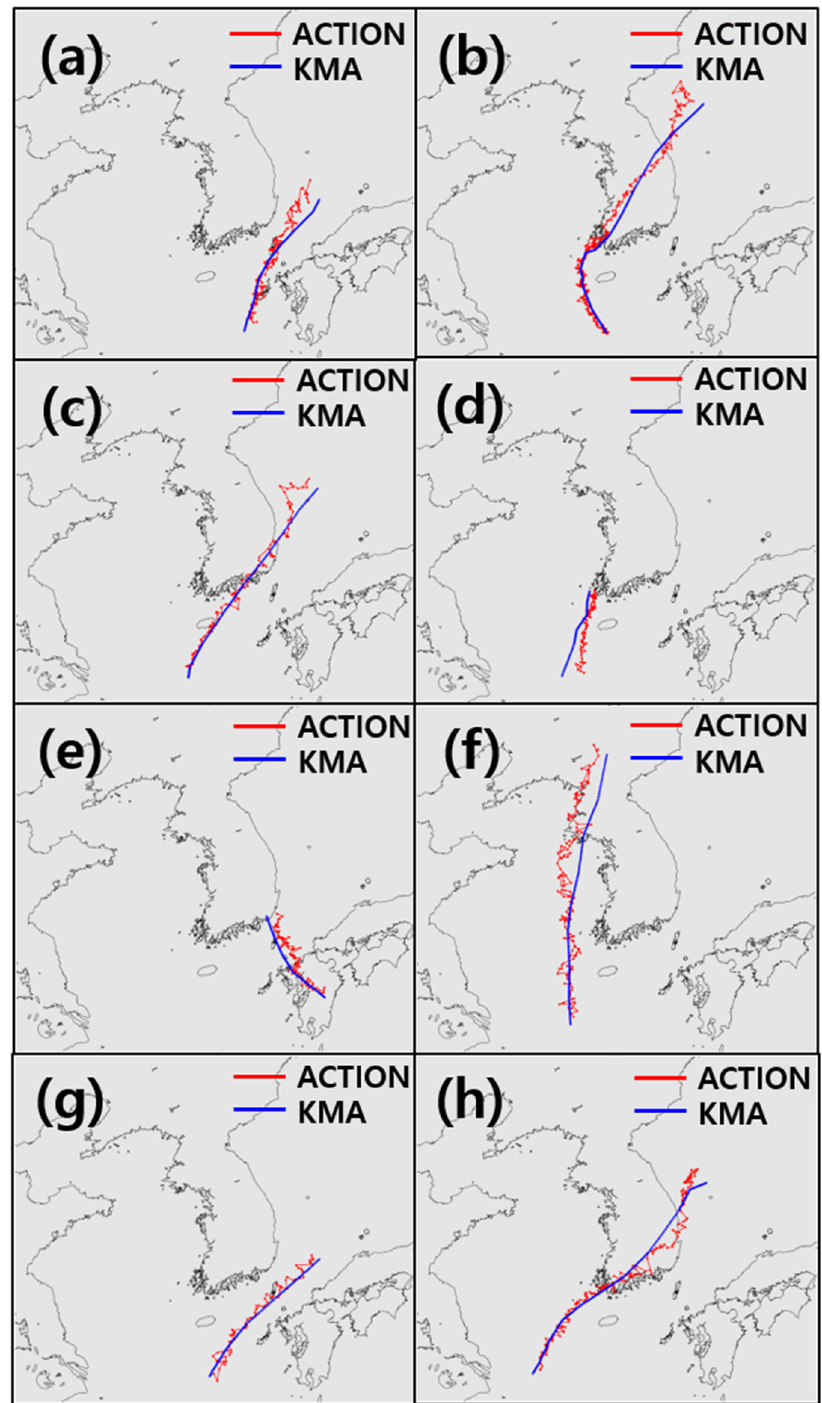
Figure 9. Comparison of ACTION results and KMA best track of typhoons that affected the Korean Peninsula between 2018–2019: ( a ) “PRAPIROON”, ( b ) “SOULIK”, ( c ) “KONG-REY”, ( d ) “DANAS”, ( e ) “FRANCISCO”, ( f ) “LINGLING”, ( g ) “TAPAH”, and ( h )